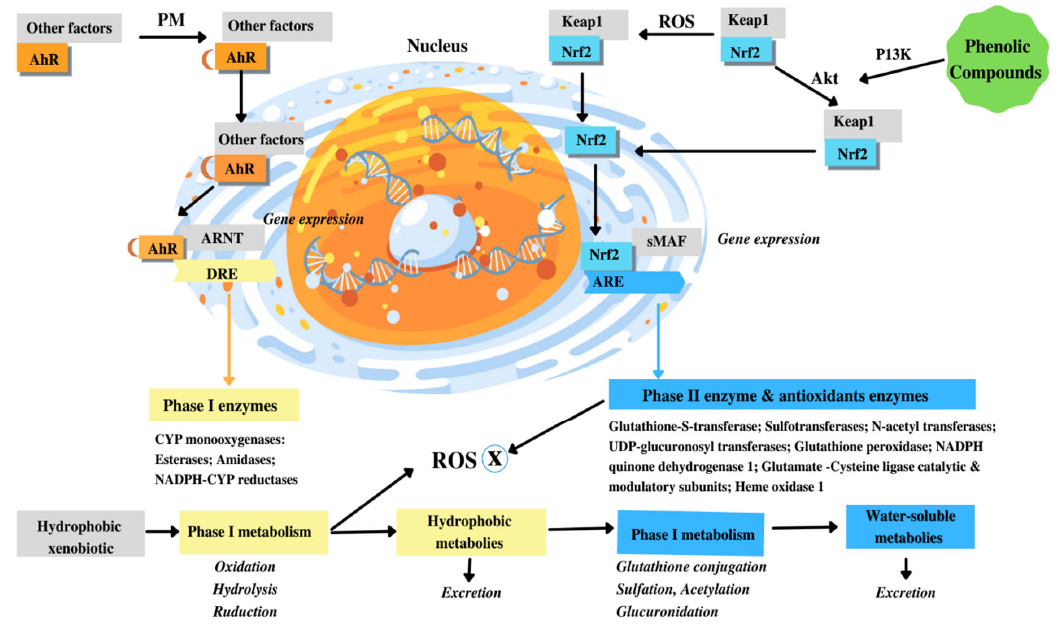
Figure 2. Induction of ROS by various factors and the role of phenolic compounds. With regard to cosmetic activity, one of the most important properties of flavonoids binding to proteins is their affinity for both types of estrogenic receptors. Isoflavones have a powerful effect. Genistein’s affinity for estrogen receptors and 17 ‐ estradiol is estimated to be 0.7% and 13.0%, respectively [196]. Binding of genistein or another flavonoid elicits receptor dimerization and appropriate gene induction. Hence, this activity is comparable to typical estrogen activity [197]. A higher plasma concentration of the active property compensates for the relatively low activity (estimated in relation to the activity of estro ‐ genic receptors and 17 ‐ estradiol as 0.025% and 0.8%, respectively) [198]. The anti ‐ inflam ‐ matory activity of flavonoids demonstrates their multi ‐ activity. This action is commonly